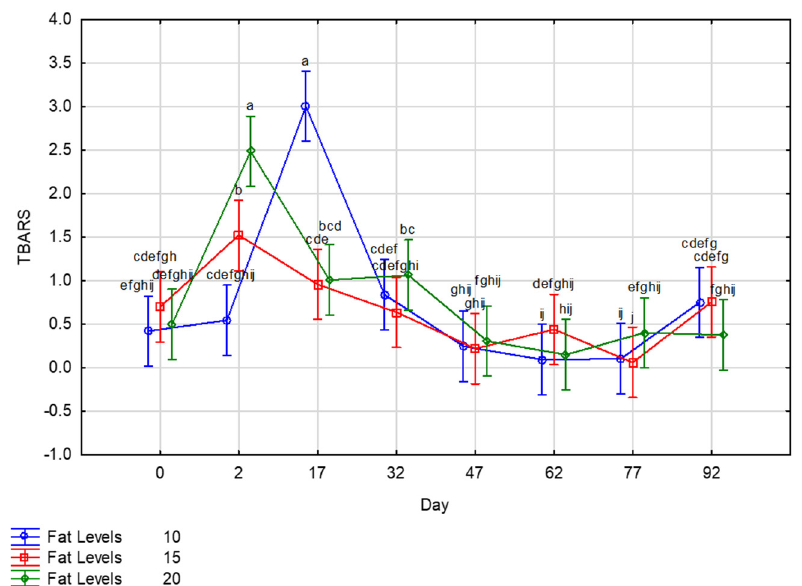
Figure 3. TBARS of zebra droëwors made with different sheep fat levels before drying (day 0), after drying (day 2), and during storage at 25 °C, under vacuum (day 17–92). TBARS: MDA mg eq/kg (eq = equivalent). a–j Means with different superscripts differ ( p ≤